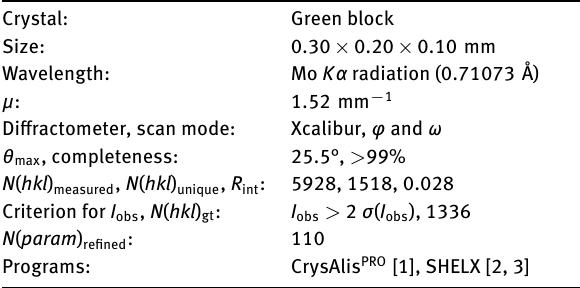
Table 1: Data collection and